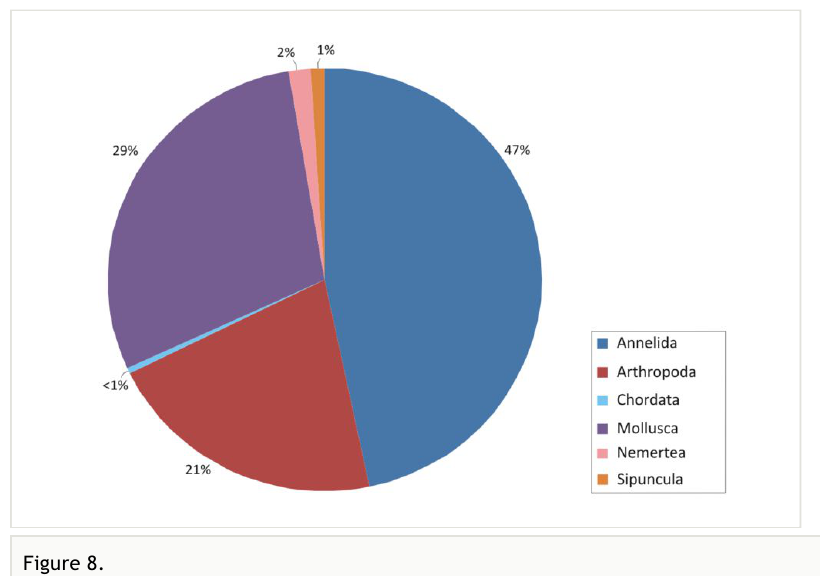
Figure 8. Percentages of main phyla in the winter samples of Greece, as calculated based on the individual count of species per total sponge volume.